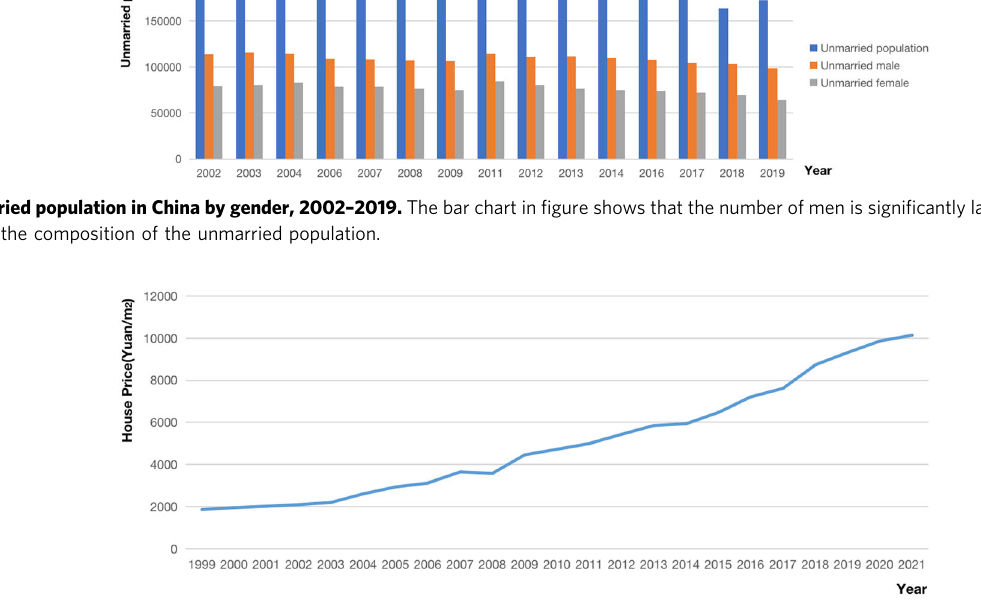
Fig. 4 Housing prices in China, 1999 – 2021. Figure indicates the continuous upward trend of housing prices in China from 1999 to